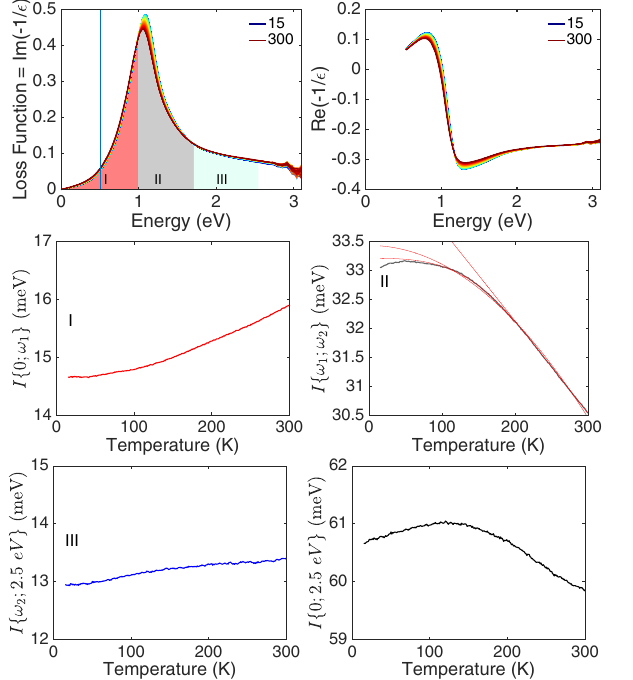
FIG. 12. Sample Bi2212-84-OD. Caption details as in Fig. 8. The value of the fitted exponent α is 2 when fitting down to T and 1 and 3 when splitting into T windows.